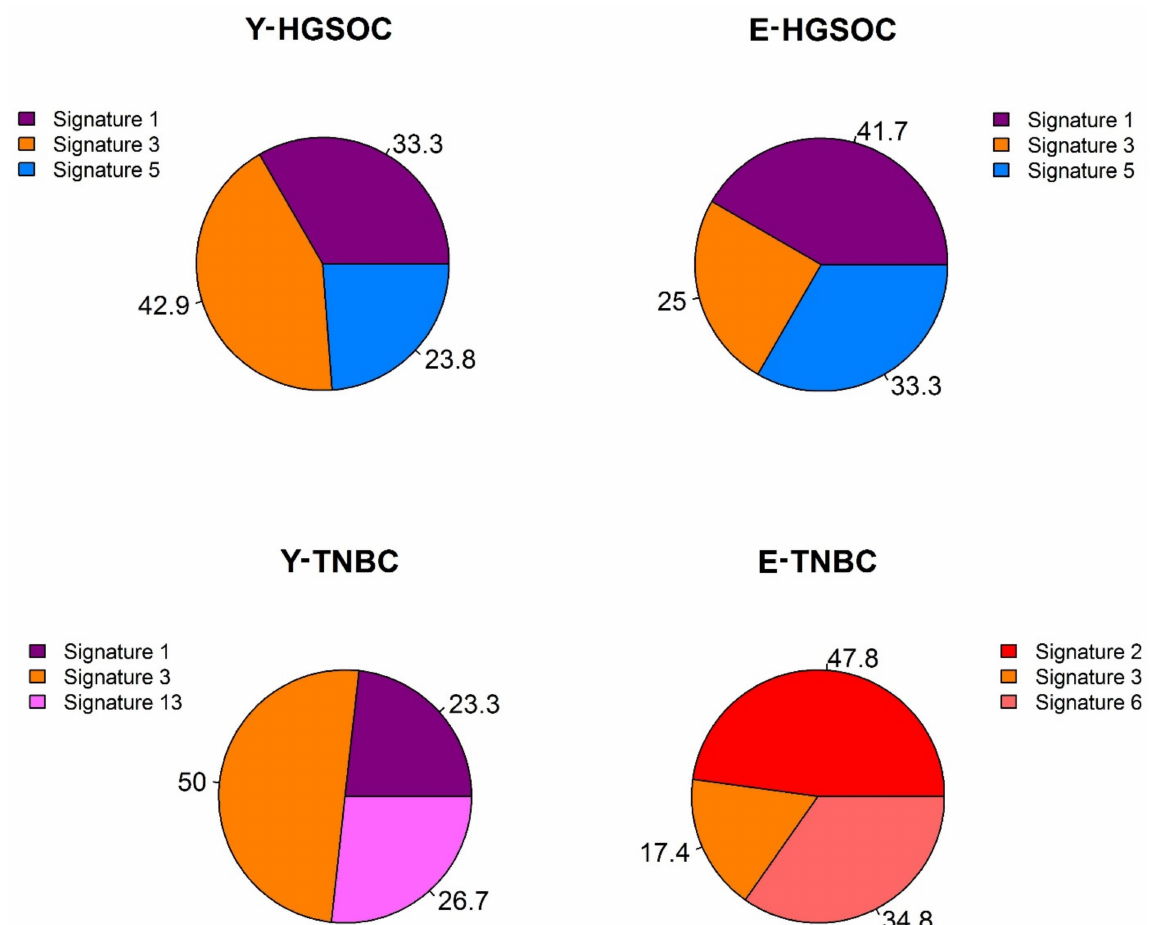
Figure 2. Mutational signatures: The pizza plots show the distribution (%) of the signatures across age groups in both cancer types. Y-HGSOC: young HGSOC patients; E-HGSOC: elderly HGSOC patients; Y-TNBC: young TNBC patients; E-TNBC: elderly TNBC